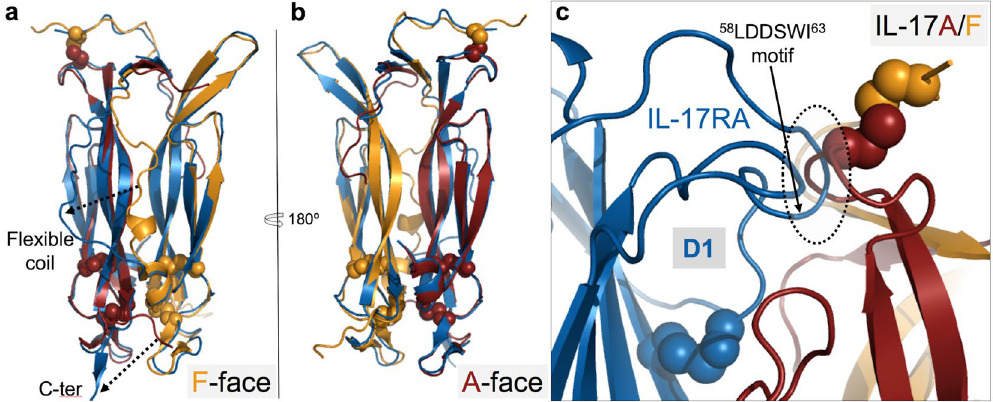
Figure 6. Least square superposition of the free- (carmine/orange ribbon) and IL-17RA-bound states (blue ribbon) of IL-17A/F, using a maximum matching distance of 1.2Å. ( a ) Receptor view of the “F-face” of the cytokine. Note the large conformational changes affecting the flexible coil and C-terminal tail. ( b ) Receptor view of the “A-face”. Note the high similarity of the free- and “F-face”-receptor-bound states. ( c ) Close-up view of a model showing the IL-17RA (blue ribbon) bound to the “A-face” of IL-17A/F. The receptor position was generated by applying the transformation that best superimposes the F-subunit onto the A-subunit. Note the steric hindrance (dotted circle) between the β 3– β 4 loop of the cytokine and the loop of IL-17RA bearing the key 58 LDDSWI 63 binding